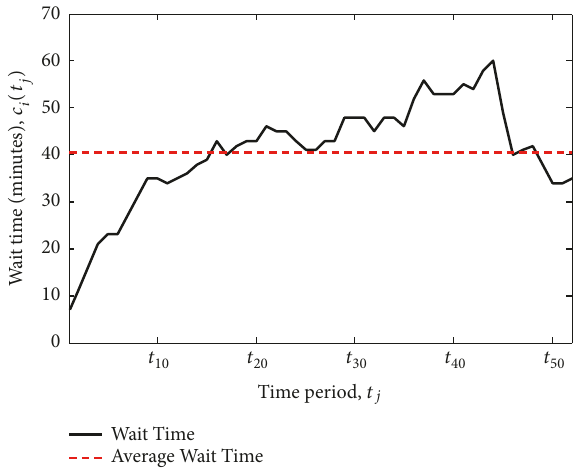
Figure 2: Wait time data for an attraction shown with 15 minute time periods. Dashed line demonstrates the average wait time, 𝑐 𝑖